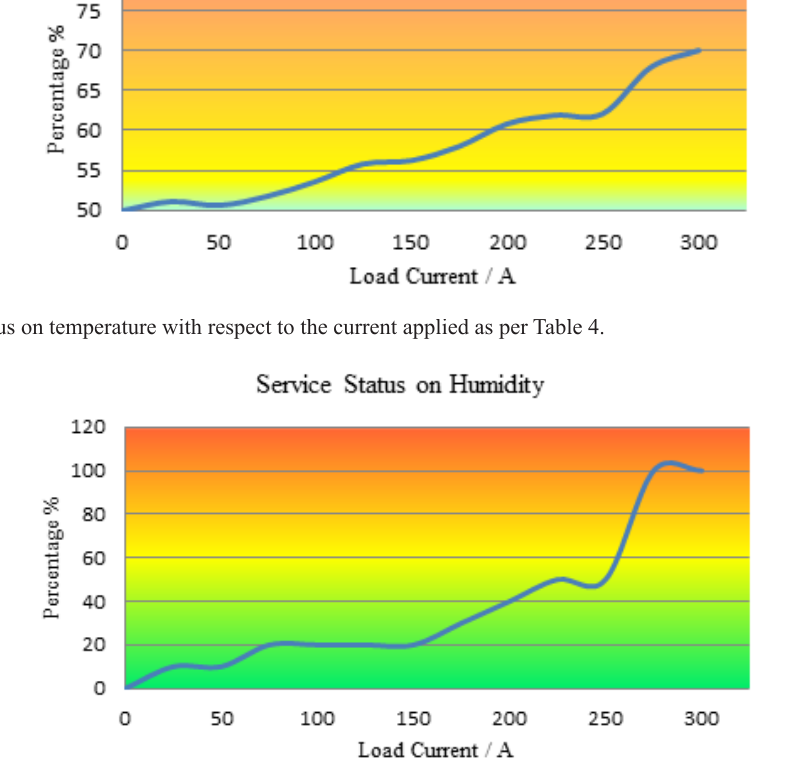
Figure 8: Service status on humidity with respect to the current applied as per Table 5.